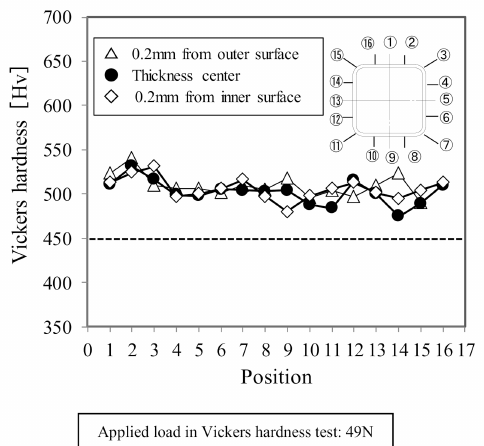
Figure 6. Circumferential hardness distribution of 3DQ product (40 mm × 40 mm and thickness 1.8